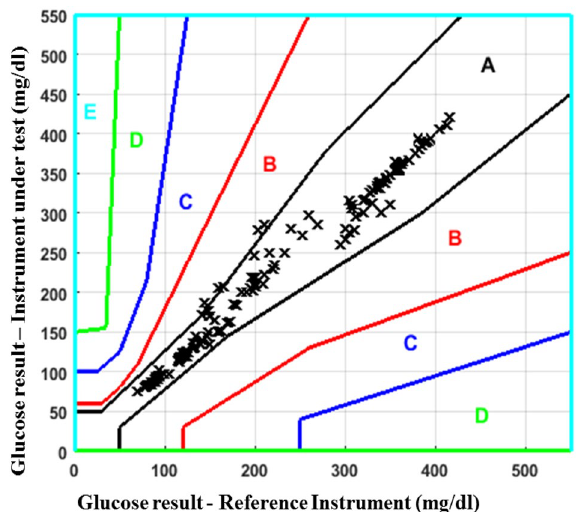
Figure 8. Parke‘s error grid analysis for